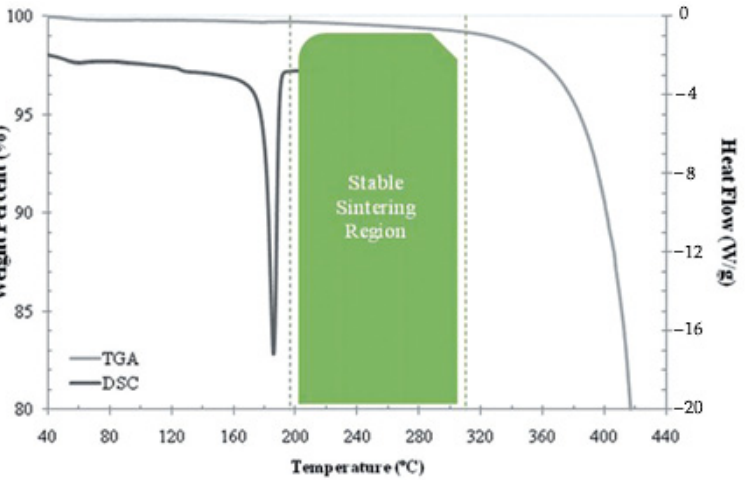
Figure 10. “Stable sintering region” for thermoplastic polymers. Adapted from [90].